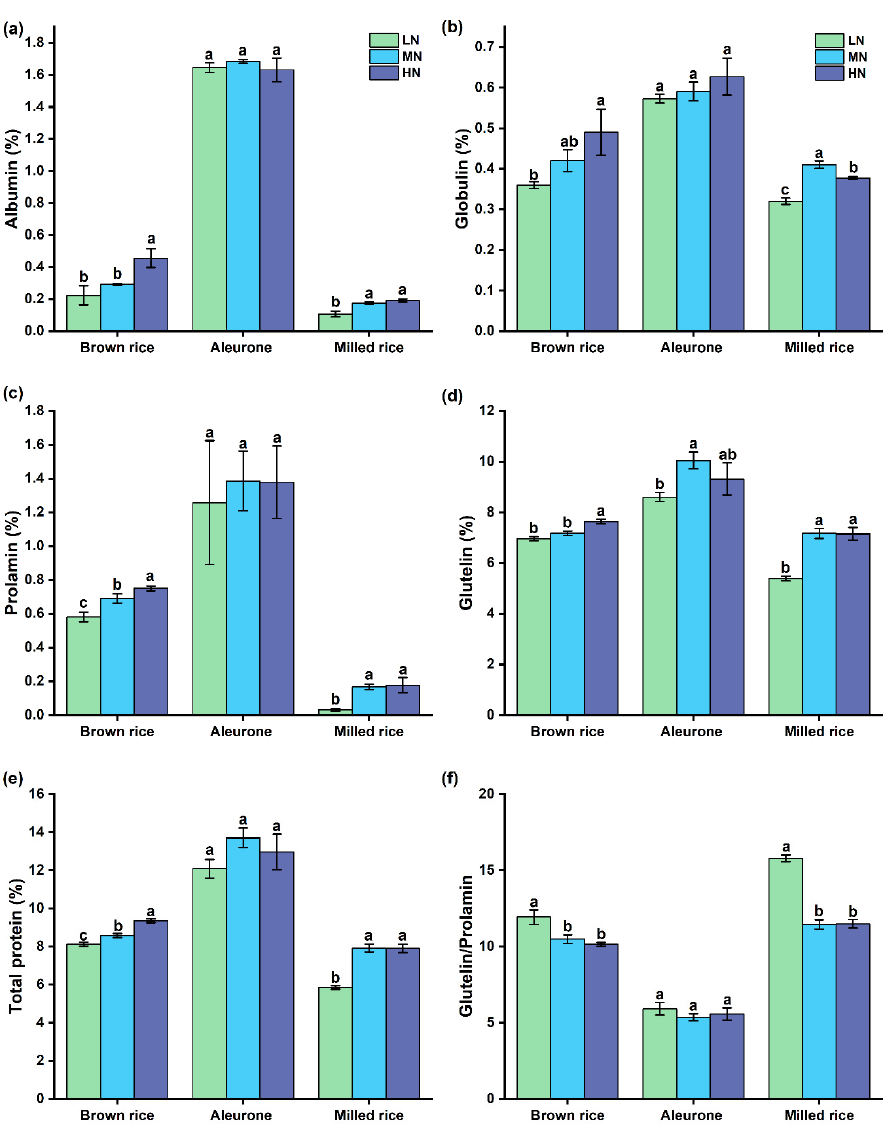
Figure 1. Effect of N levels on ( a ) Albumin (%), ( b ) Globulin (%), ( c ) Prolamin (%), ( d ) Glutelin (%), ( e ) Total protein (%), ( f ) Glutelin/Prolamin in different rice grain fractions, including brown rice, milled rice, and aleurone (XS110 of 2016 in hydroponic culture). LN: low nitrogen level; MN: me- dium nitrogen level; HN: high nitrogen level. Bars indicate the mean ± SE. Different letters for every three N levels (LN, MH, HN) of each grain fraction denoted significant differences according to a one-way ANOVA analysis followed by Tukey’s multiple comparison test. In detached panicle culture, the effect of N application on grain protein concentration was more prominent, especially at high N levels (Table 3). With the increase in N levels, grain protein and their fractions showed a significant and progressive increment, but high N levels (N4) did not result in an additional contribution to the increase in grain weight;